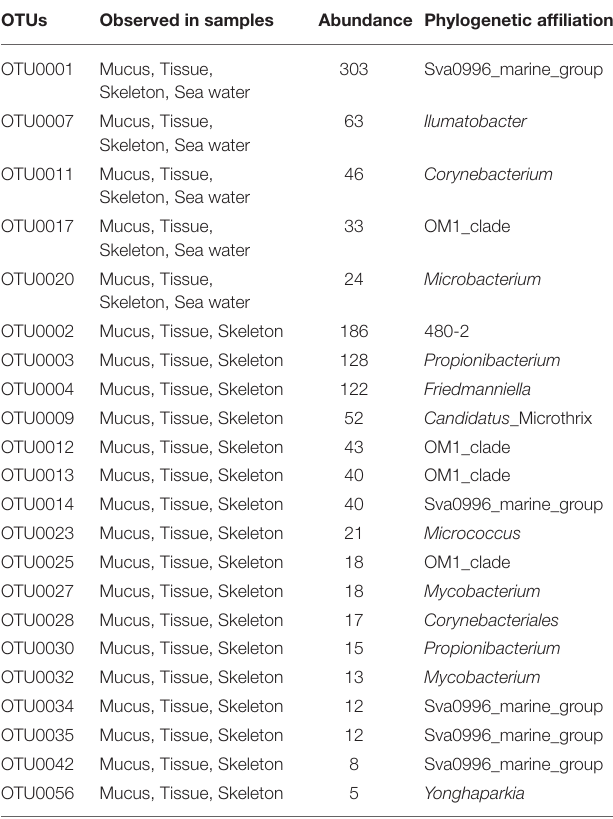
TABLE 3 | OTUs presented in P. lutea collected in four different months.